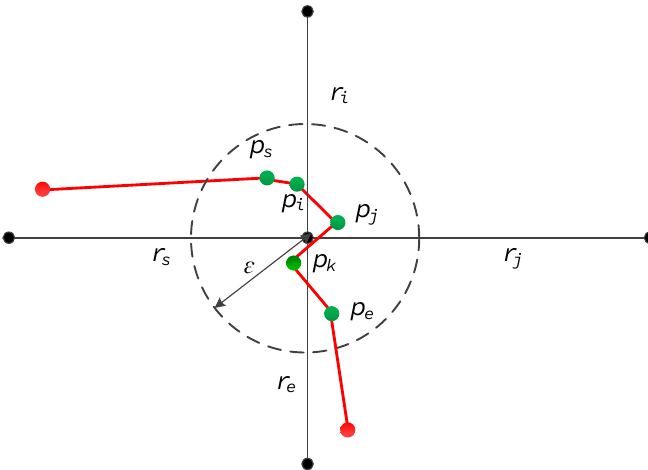
Figure 2. Examples of related concepts. There are four road sections, r s , r e , r i , r j , which are connected in an intersection o , and they form a road network. ε is the radius of the acquisition error. Trajectory points from p s to p e are intersection trajectory points, and they are connected as intersection trajectory segments. p s and p e are inbound and outbound points, respectively. r s is an inbound road section, and r e is an outbound road section.